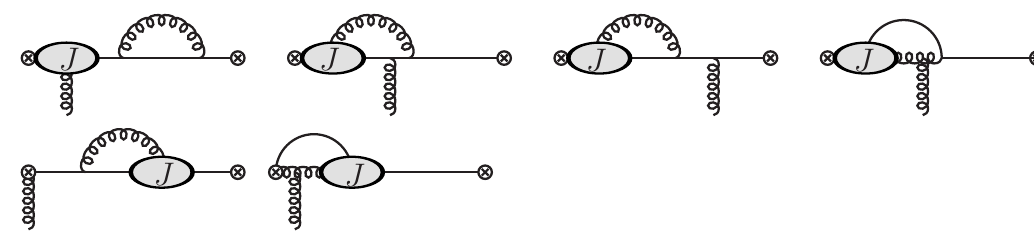
Figure 4: Representative Feynman diagrams contributing to the renormalization of the jet function at one-loop order in light-cone gauge. The blob represents the inser- tion of the jet function at one-loop